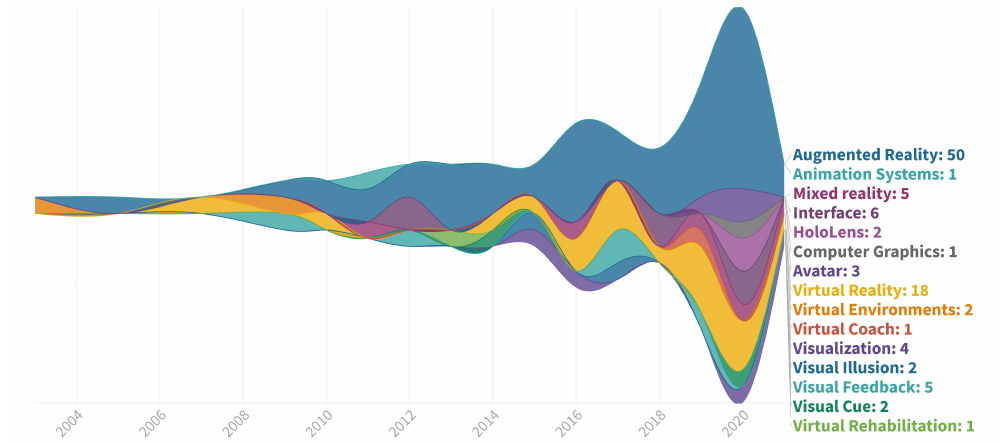
Figure 5. Usage of visualization-related keywords in the selected